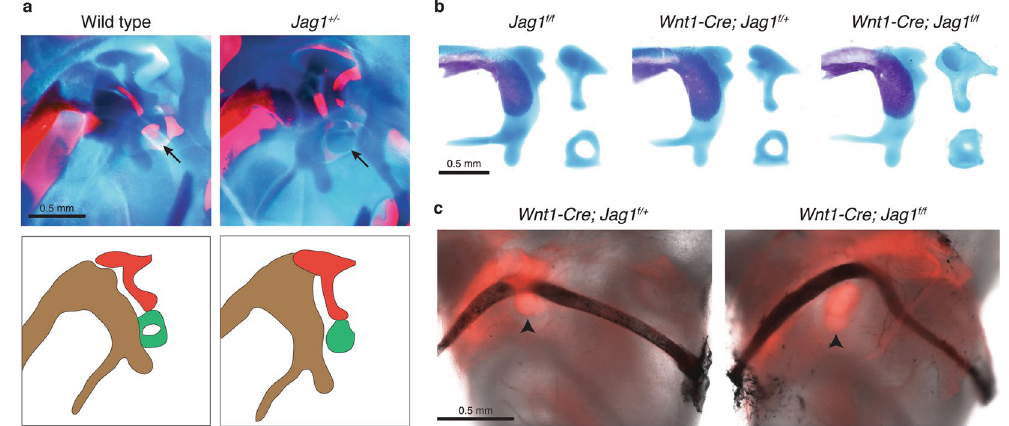
Figure 2. Mispatterning of middle ear cartilages and formation of the stapedial artery in Jag1 -deficient mice. ( a , b ) Newborn mice were stained with Alcian Blue for cartilage and Alizarin Red S for bone. Close-up views show the developing middle ear, which is diagrammed below for wild-type and Jag1 heterozygous mice (malleus, brown; incus, red; stapes, green). Dissected middle ear cartilages are shown for conditional mutants. Arrows point to the stapes cartilage, which is reduced in size in both heterozygous and conditional Jag1 mutant mice. ( c ) The stapes of Wnt1-Cre ; Jag1 f/ + ; Rosa26-Tomato and Wnt1-Cre ; Jag1 f/f ; Rosa26-Tomato mice fluoresce red and the stapedial arteries appear black from India ink injection. The artery is still present in Jag1 -CKO mice, where it deviates around the misshapen stapes cartilage. Arrowheads point to the